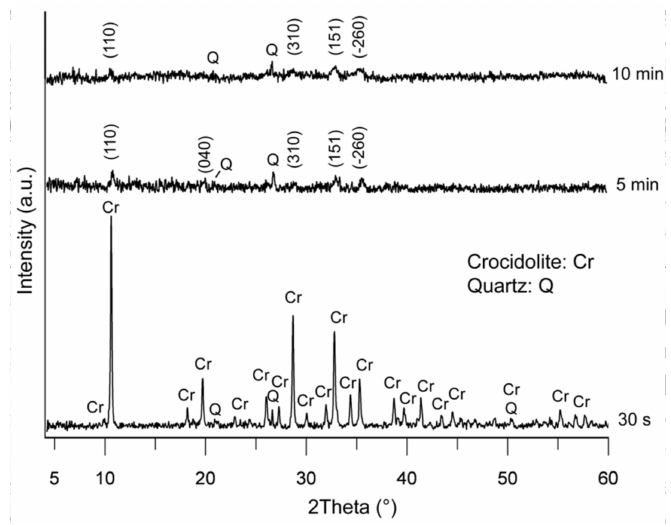
Figure 3. XRPD patterns of crocidolite recorded after 30 s, 5 min and 10 min of grinding time.